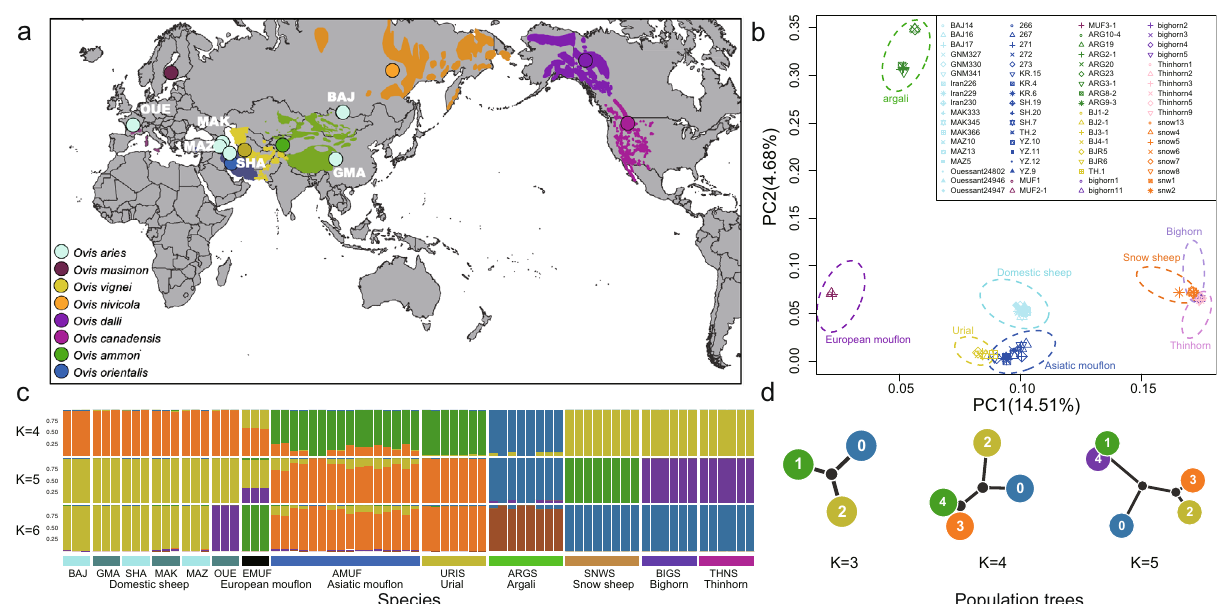
Fig. 1 Geographic distribution and population structure of Ovis species. a Geographic map of sample locations and wild sheep species distribution based on the IUCN Red list (https://www.iucnredlist.org). Here we adopted the classi fi cation of Nadler et al. 66 . b Principal Component Analysis (PCA) of Ovis species. c Admixture plot using Ohana software for K from 4 to 6. d Population tree of each K indicates af fi nity of each ancestral component. Source data for b , c were presented in Supplementary Data 7.